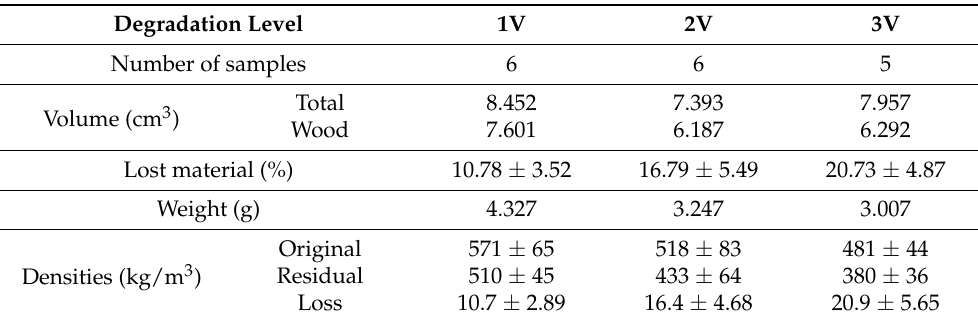
Table 5. Initial sample distribution. Average values and relative standard deviations for the output parameters, mass, density, and loss of